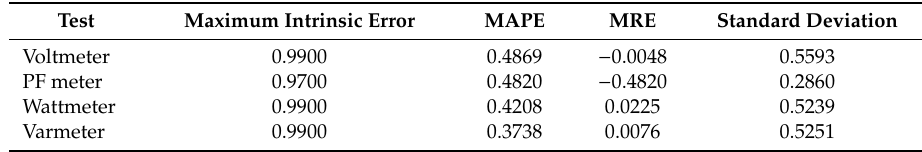
Table 5. Current magnitude distortion test: maximum intrinsic error (%), MAPE (%), MRE (%), and standard deviation (%): voltage variation.